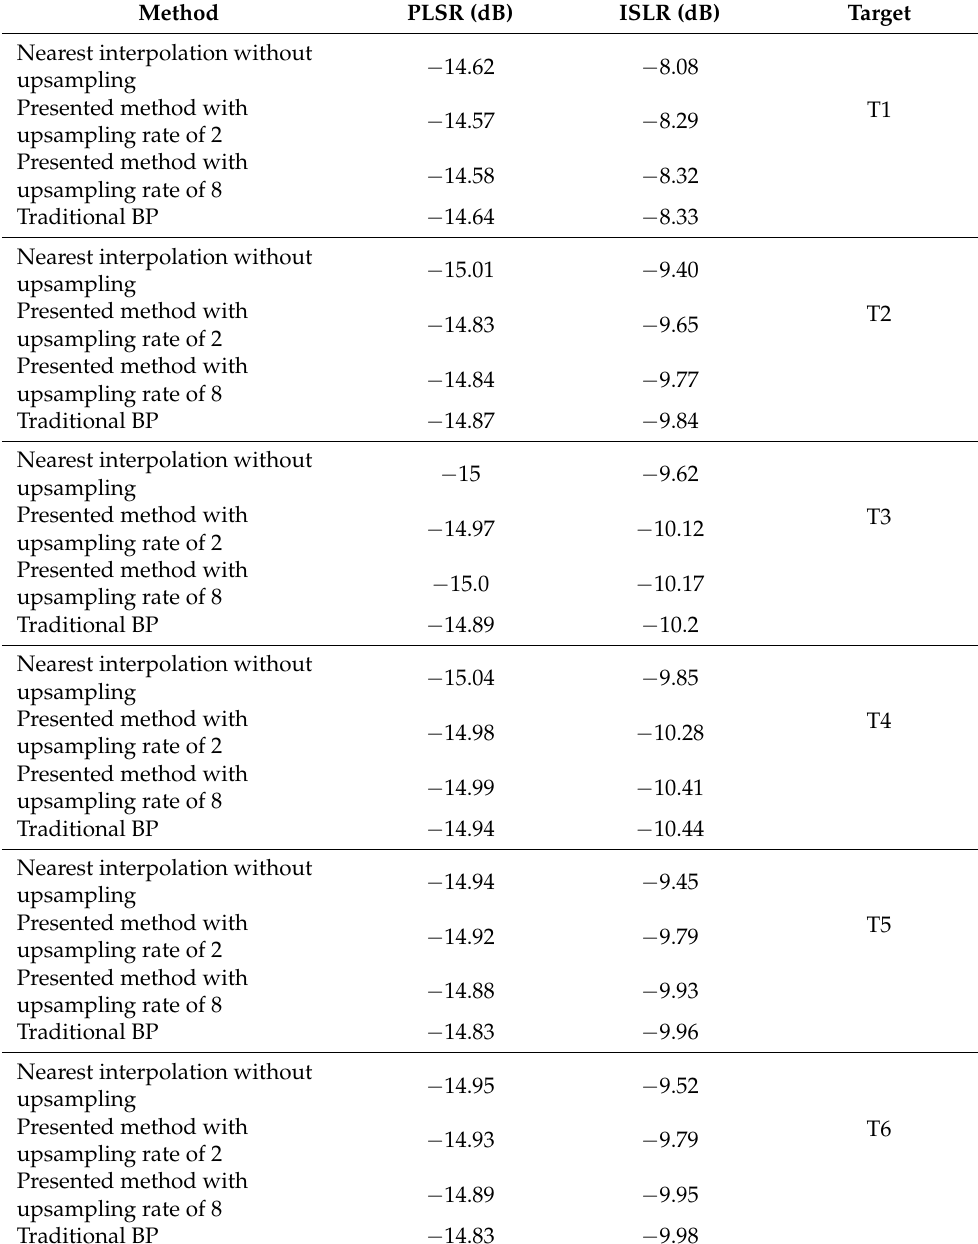
Table 3. Quality parameters of focused